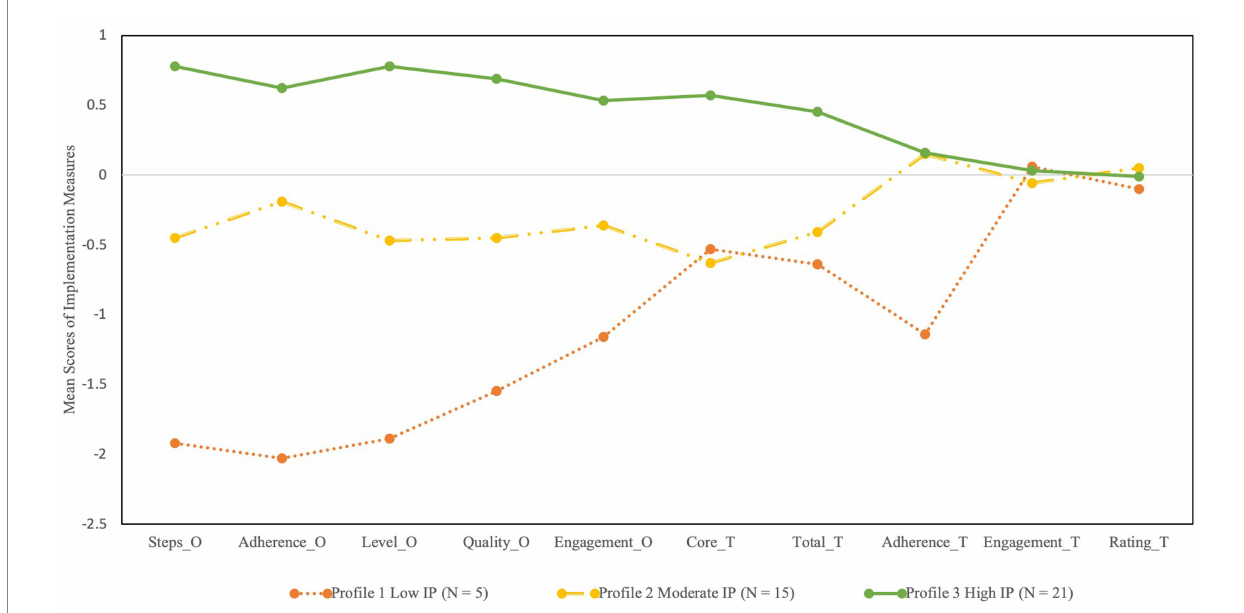
FIGURE 1 Mean scores of implementation measures by profile. Steps_O, Observed steps; Adherence_O, Observed adherence; Level_O, Observed level of implementation; Engagement_O, Observed student engagement; Core_T, Teacher reported number of core lessons taught; Total_T, Teacher reported number of total lessons taught; Adherence_T, Teacher reported adherence; Engagement_T, Teacher reported student engagement; Rating_T, Teacher’s weekly impression rating of